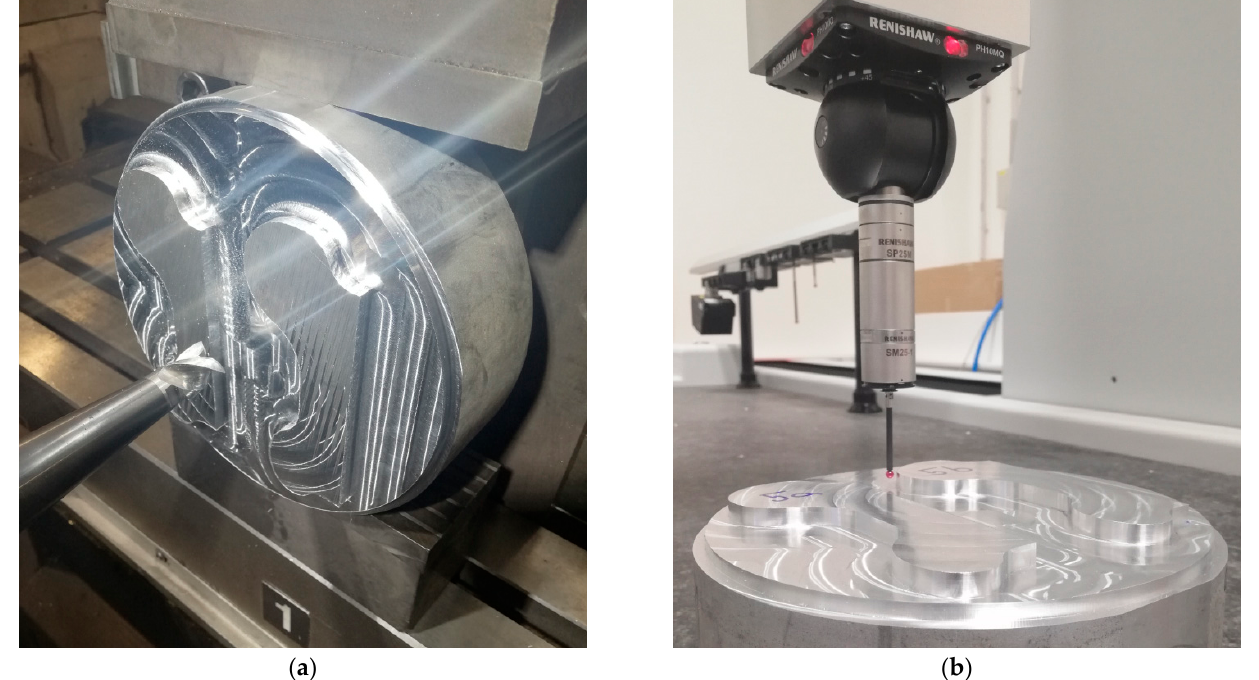
Figure 12. Machining and measuring of the workpiece: ( a ) machining on a three-axis machining center; ( b ) measuring on CMM using a Renishaw SP25M scanning probe.